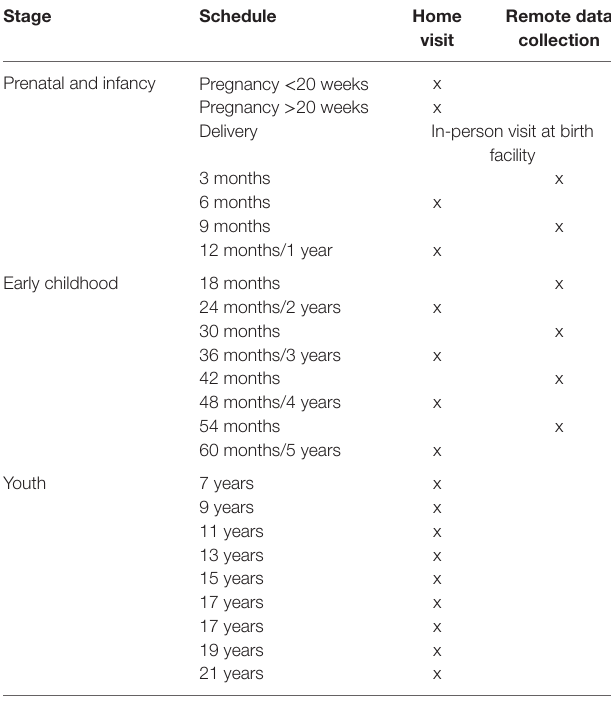
TABLe 2 | Revised National Children’s Study Vanguard Study visit schedule from 2010.